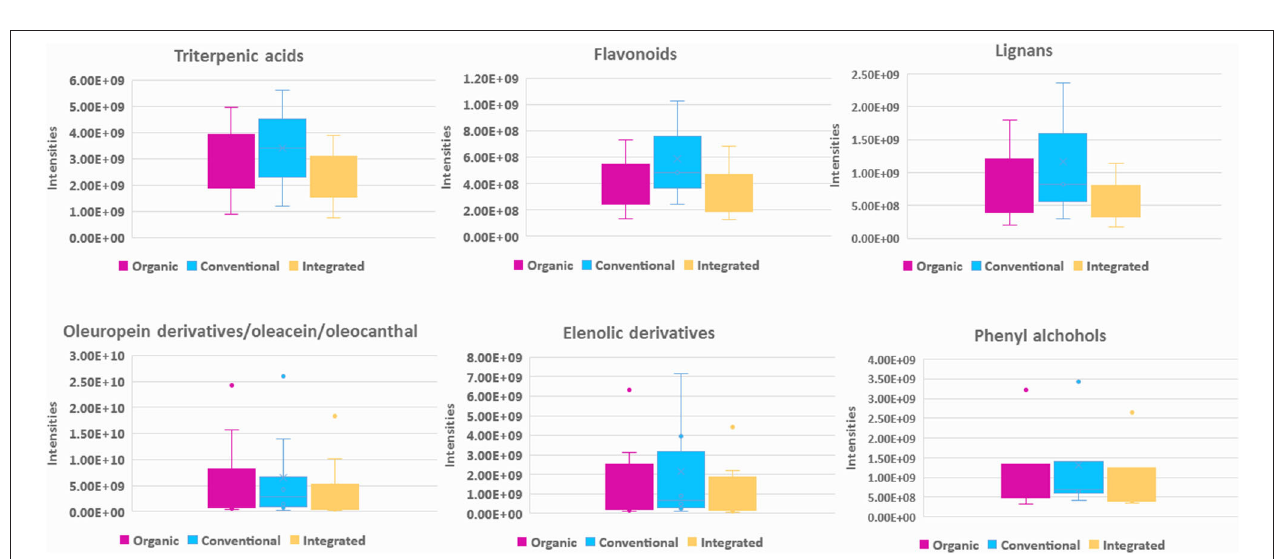
FIGURE 6 | Scores plots of EVOOs and their corresponding biophenol extracts acquired via FIA-MRMS. Plots include the total number of observations and are colored coded according to cultivation practice classID; conventional (blue), integrated (light orange), and certified organic practices (magenta). (A) OPLS-DA scores plot of EVOOs with pareto scaling; (B) OPLS-DA scores plot of biophenols with UV scaling. R2/Q2 model parameters are annotated (bottom-left).